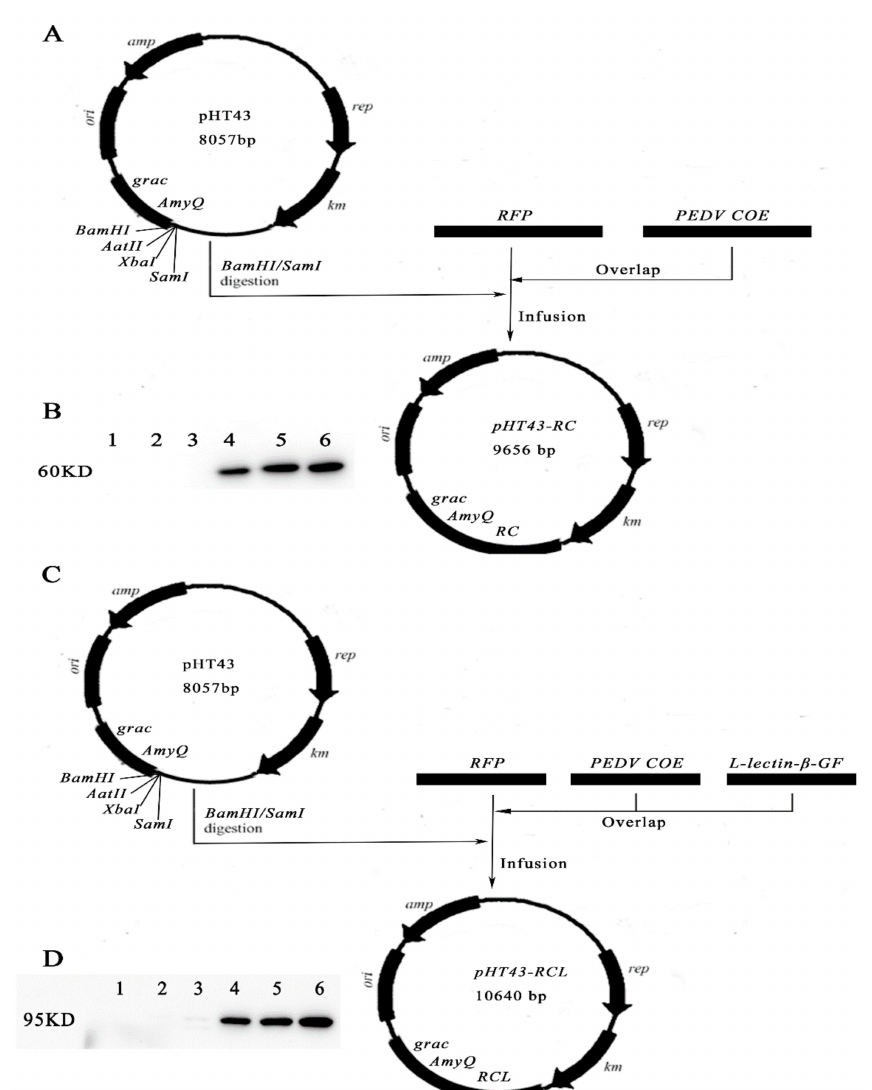
Figure 2. The construction of the recombinant plasmid and its fusion protein expression. ( A ) The RFP and PEDV S COE gene fragments were overlapped and inserted into pHT43 to generate pHT43 -RC. ( B ) Western blotting detected the recombinant RFP-COE protein (lanes 1, 2 and 3; B. subtilis WB800N; lanes 4, 5 and 6 and B. subtilis RC). The protein bands were approximately 60 kDa, expected at the size of fusion RFP-COE. ( C ) The RFP, PEDV S COE gene and L-lectin- β -GF fragments were overlapped and inserted into pHT43 to generate pHT43 -RCL. ( D ) Western blotting detected recombinant RFP- COE- L-lectin- β -GF (lanes 1, 2 and 3; B. subtilis WB800N; lanes 4, 5 and 6 and B. subtilis RCL). Protein bands were approximately 95 kDa, expected at the size of the fusion RFP-COE- L-lectin- β -GF, were